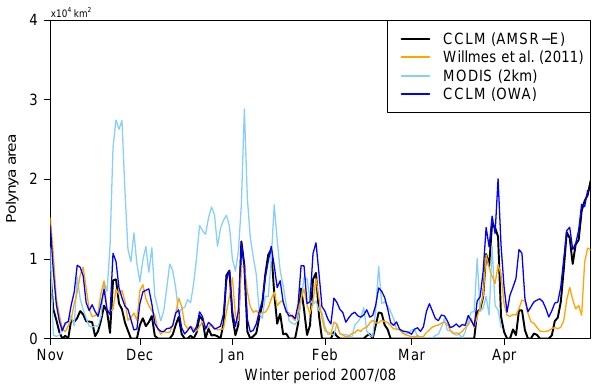
Figure 5. Total daily polynya area interpolated from AMSR-E (us- ing a 70% threshold) onto the CCLM 5km grid in the Laptev Sea for the winter period 2007/2008 aggregated for the four polynya masks. In addition, the polynya area plus open-water area (OWA = 1 − SIC) for the polynya masks is shown. Based on remote sensing the polynya areas estimated from Willmes et al. (2011a) and MODIS2km data are shown. The total area of the polynya masks is 26.19 × 10 4 km 2